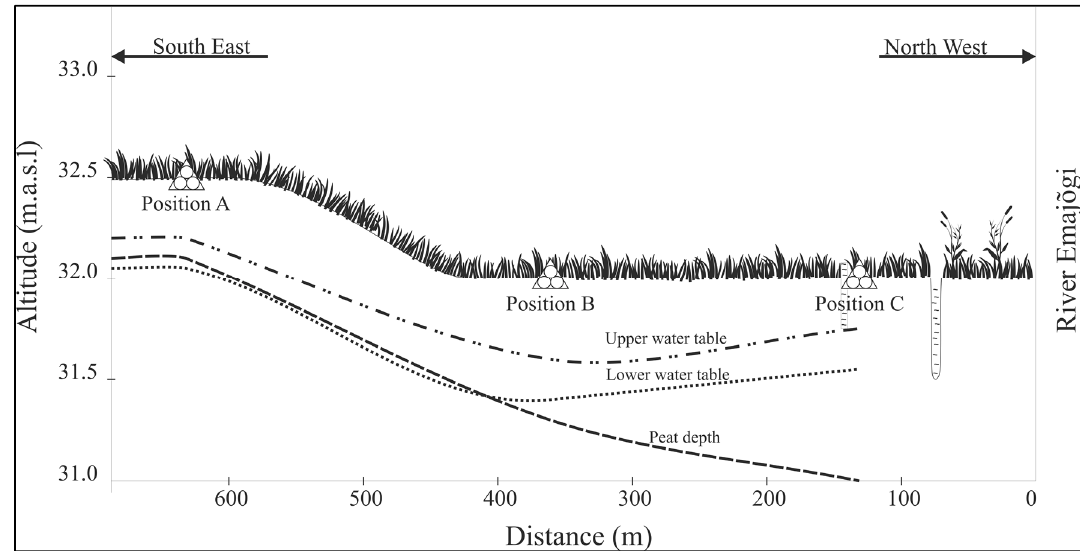
Figure 1. Study site view showing varying ground water level and peat depth at Kärevere in Tartu, Estonia.